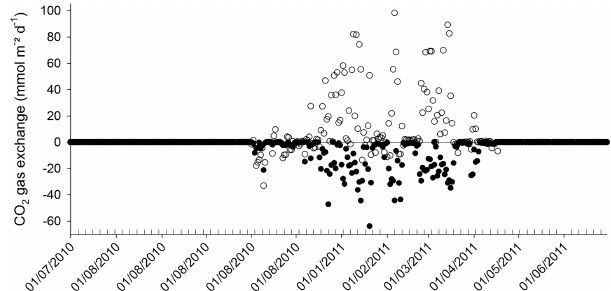
Figure 4. Daily CO 2 balance of the Boodjamulla biocrust. Black dots stand for dark respiration and open circles stand for gas ex- change during daylight. Negative values during daylight indicate either supersaturation or water